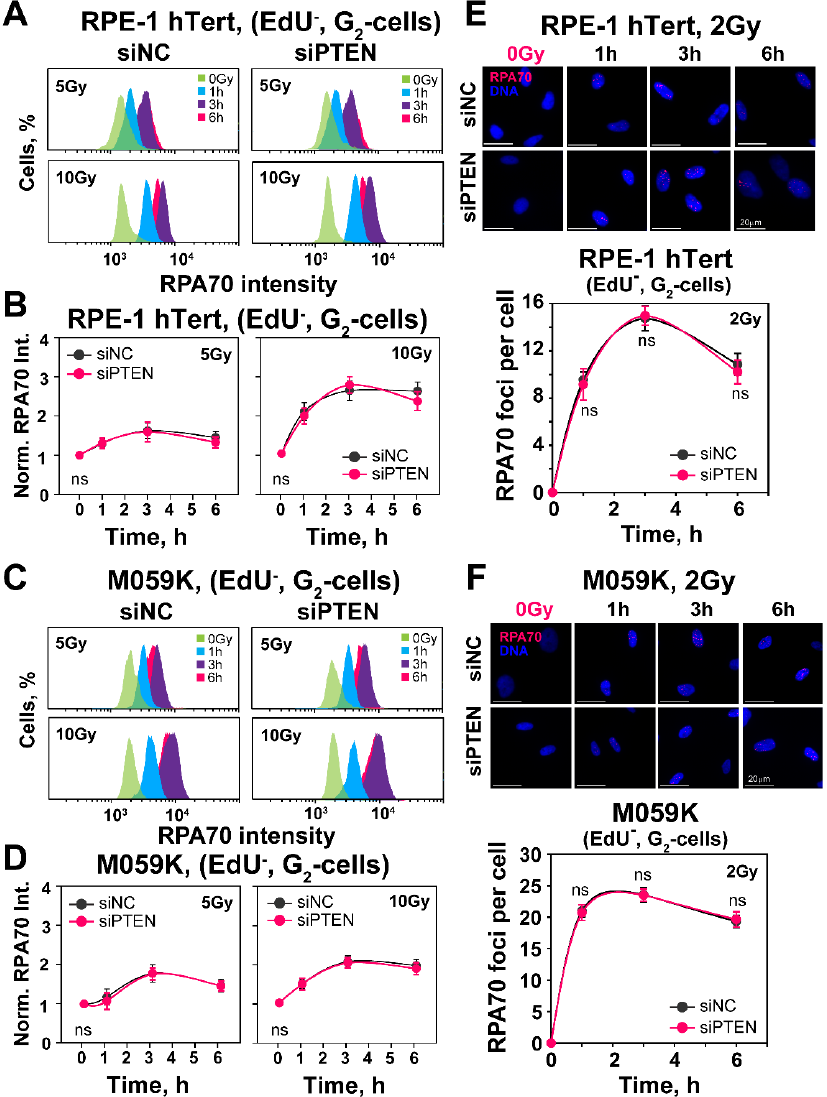
Figure 4. PTEN knock-down fails to change DNA-end-resection in RPE-1 hTert or M059K cells. ( A ) Representative flow cytometry histograms of RPA70 intensity signal in EdU-negative, G 2 -phase RPE-1 hTert cells (EdU − , G 2 -cells). ( B ) Quantification of the data shown in panel ( A ). The radiation effect on DNA end resection is shown after normalization of RPA70 signal, by dividing the mean signal intensity of irradiated cells by that of non-irradiated cells. ( C ) Same as panel ( A ), but for M059K cells. ( D ) Same as panel ( B ), but for M059K cells. ( E ) Representative IF images of RPA70 foci in exponentially growing RPE-1 hTert cells exposed to 2 Gy of X-rays. RPA70 foci are scored in EdU-negative, G 2 -phase cells (EdU-, G 2 -cells), as described in Materials and Methods. ( F ) Same as panel ( E ), but for M059K cells. The scale bar is 20 µ m for all images. Data are means ± SD from three independent determinations. The significance level, or p -value, is calculated using the two-tailed Student ´ s t -test: ns (not significant), * p <